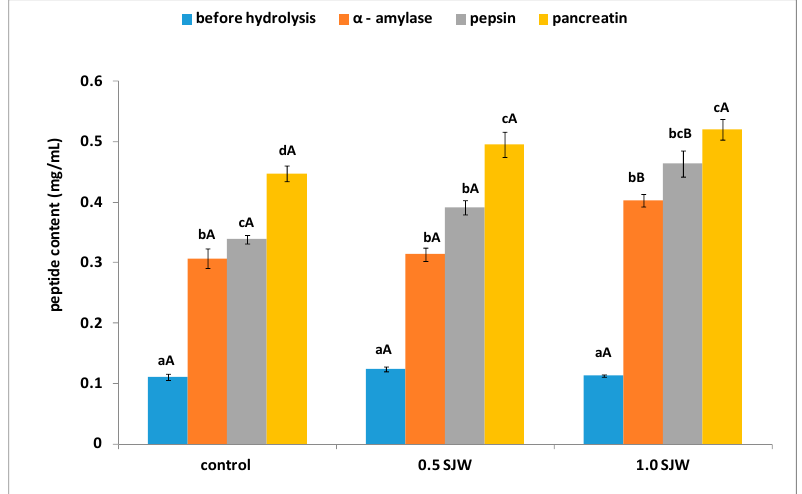
Figure 1. Peptide content during in vitro hydrolysis. Control—cookies without St. John’s wort; 0.5 SJW—cookies enriched with 0.5% of St. John’s wort; 1.0 SJW—cookies enriched with 1% of St. John’s wort. All values are mean ± standard deviation for triplicate experiments. Different capital letters at the same enzyme indicate significant differences for the same indicator ( α = 0.05). Different lowercase letters in the same samples indicate significant differences for the same indicator ( α = 0.05).